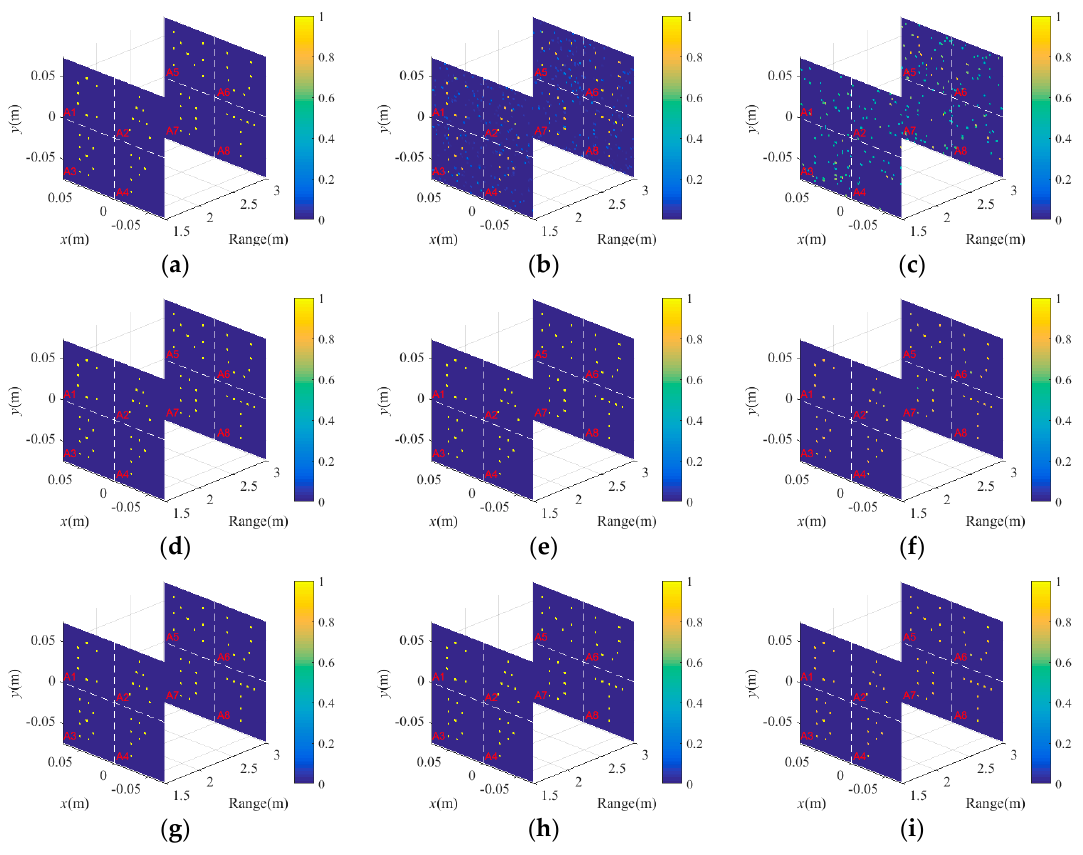
Figure 8. The imaging results of traditional TCAI under ( a ) 30 dB, ( b ) 0 dB and ( c ) − 30 dB, respectively. The imaging results of GM ‐ TCAI under ( d ) 30 dB, ( e ) 0 dB and ( f ) − 30 dB, respectively. The imaging results of BP ‐ TCAI under ( g ) 30 dB, ( h ) 0 dB and ( i ) − 30 dB, respectively.